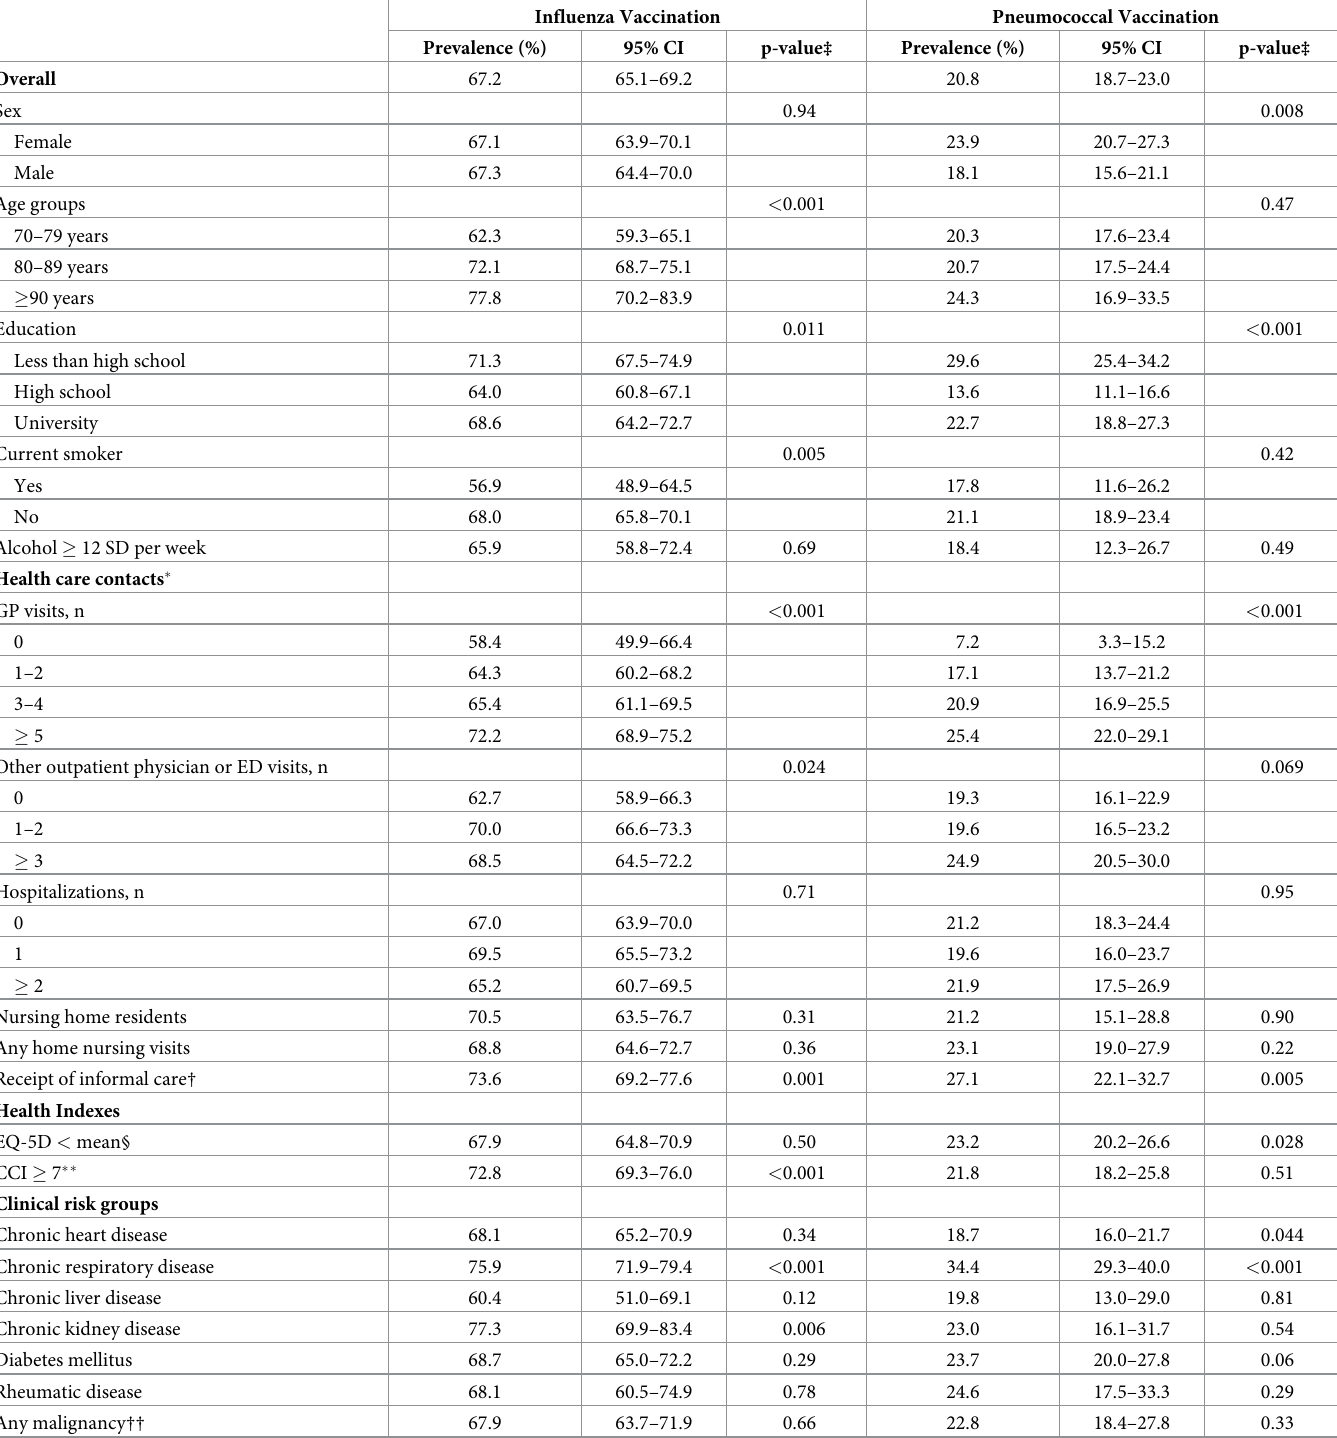
Table 2. Vaccination prevalence according to population